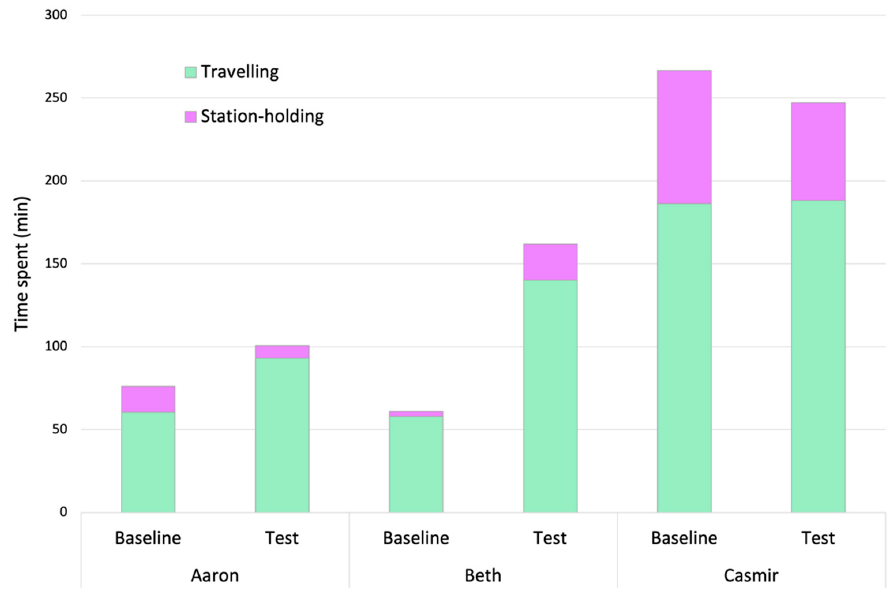
Figure 5. The observed duration of travelling (green) and station holding (purple) exhibited by the three Arapaima gigas , during baseline and test conditions; the cumulative duration of the two behaviours also indicates the presence of the three fish in the exhibit